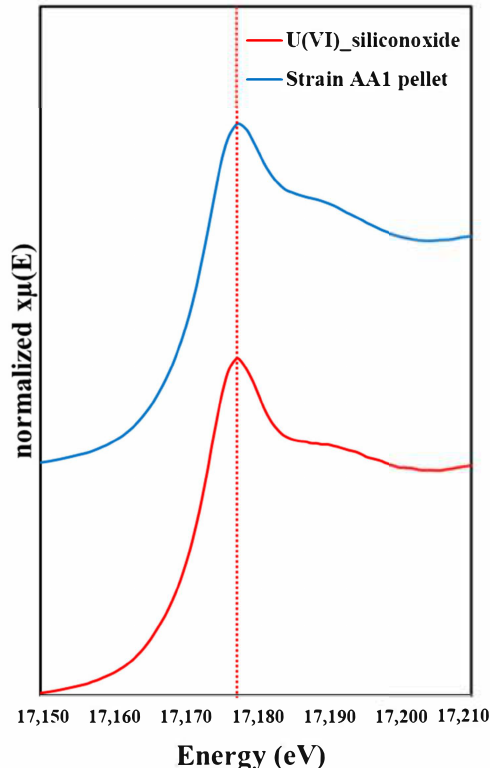
Figure 4. L3-edge XANES spectra of U(VI) biosorbed by AA1, measured using a He flow chamber to maintain anaerobic conditions. The blue line shows the spectrum for a freeze-dried sample of the U(VI) biosorbed on Parachlorella sp. AA1 cells, and the red line shows the spectrum for a U(VI) reference standard solution. The red dotted line shows the U(VI)